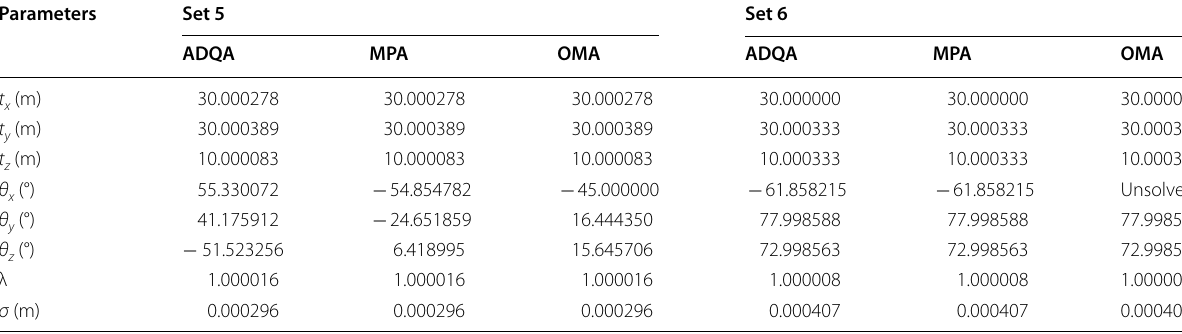
Table 13 Computed transformation parameters for Set 5 to Set 6 by ADQA, MPA, and OMA Parameters